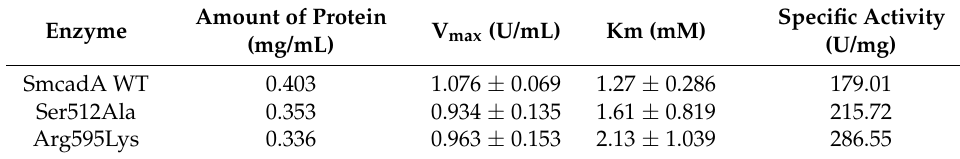
Table 2. Specific activity and kinetic parameters of wild-type SmcadA and mutants.